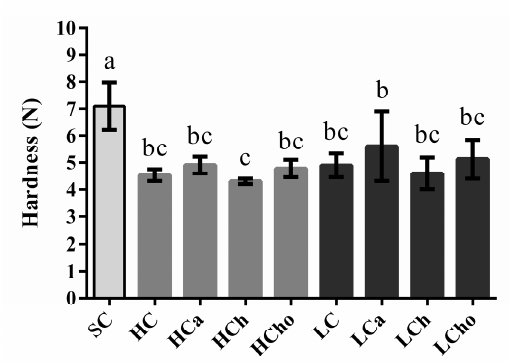
Figure 6. Effect of calcium carbonate, chitosan, and chitooligosaccharide on hardness in brown sugar cookies. a–c Indicate significant difference between different groups (n = 3; p < 0.05). SC: Sucrose cookie;